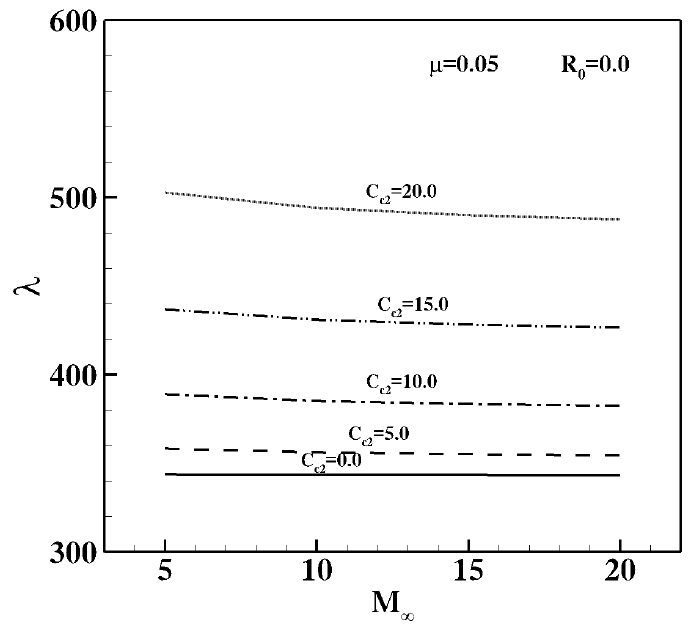
Figure 22. Variation curve of critical dynamic pressure with freestream Mach number for bifurcation of wall plate under different viscous resistances.